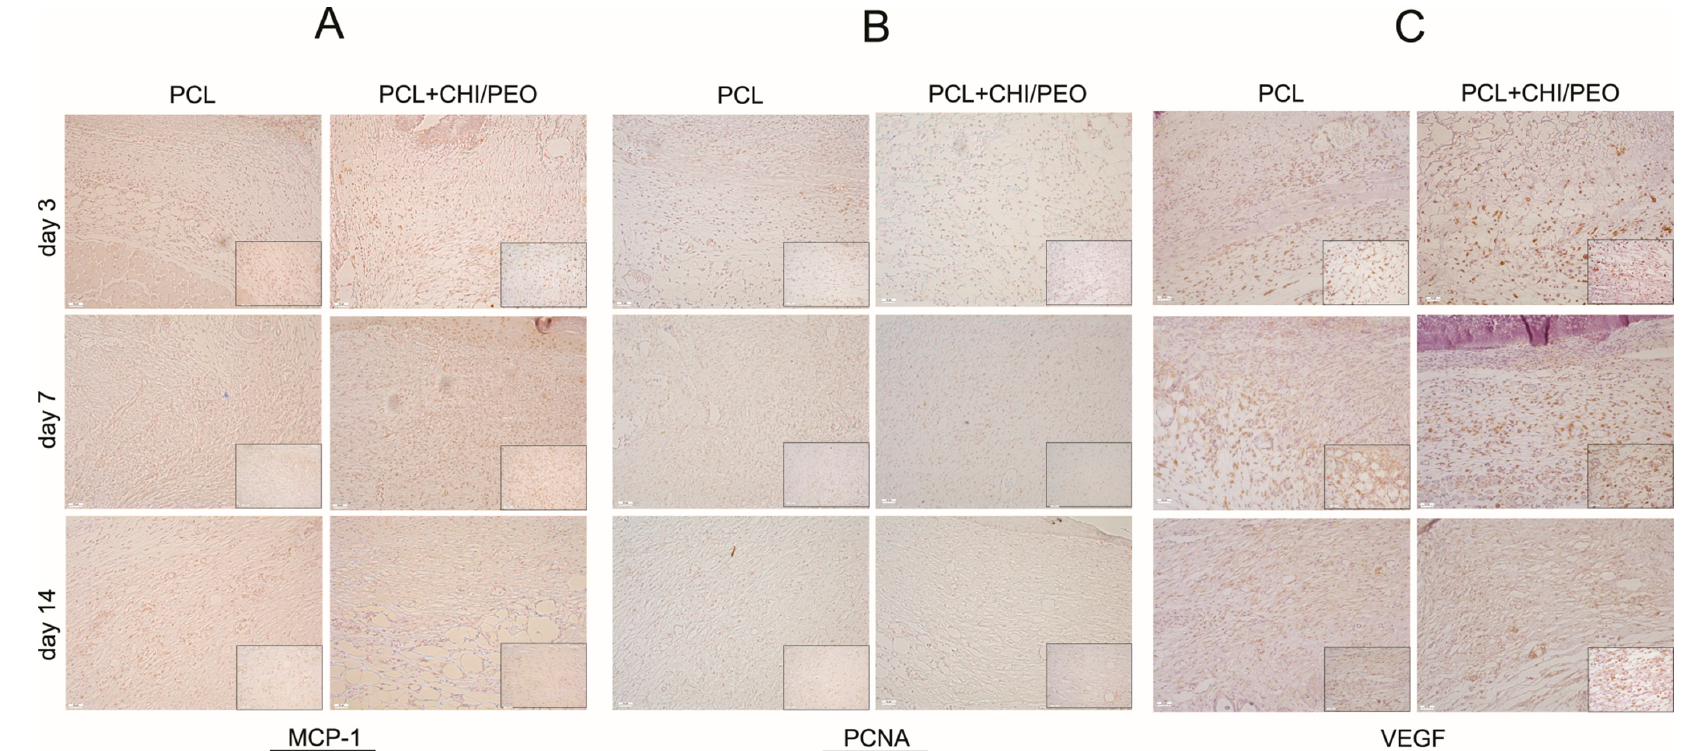
Figure 4. Immunohistochemistry for Monocyte Chemoattractant Protein-1 (MCP-1) ( A ), proliferating cell nuclear antigen (PCNA) ( B ), and vascular endothelial growth factor (VEGF) ( C ) of the areas with excisional lesions treated with PCL or PCL+CHI/PEO membrane on the 3rd, 7th, and 14th day. Objective 20× and 40× (inserts).